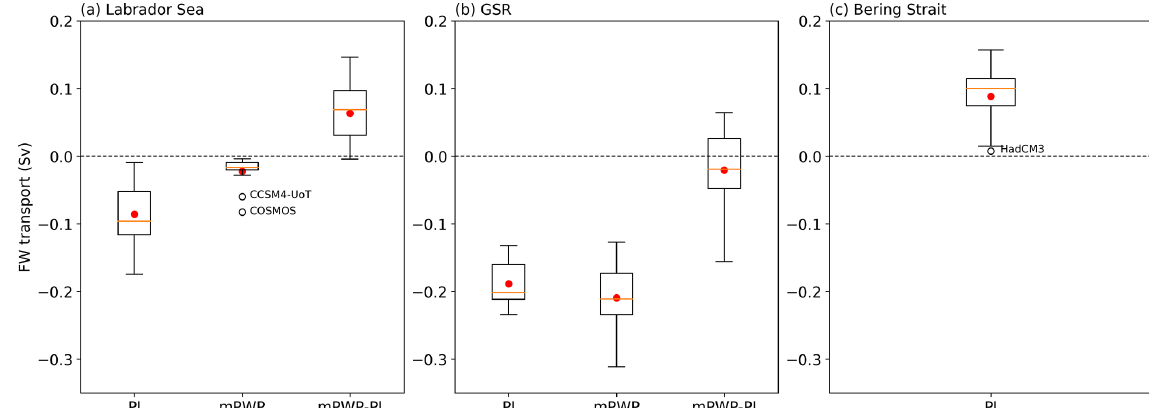
Figure 8. Boxplots of the mean freshwater transport (Sv) in the pre-industrial and mid-Pliocene and their difference at 62 ◦ N (a) near the northern boundary of the Labrador Sea and (b) across the GSR. (c) Mean freshwater transport (Sv) through the Bering Strait in the pre- industrial. The box covers Q 1 (25th percentile) to Q 3 (75th percentile), with the median indicated by a horizontal orange line. The whiskers extend from Q 1 to Q 1–1.5 × IQR (interquartile range) and from Q 3 to Q 3 + 1 . 5 × IQR, where IQR = Q 3 − Q 1. A model that falls outside the whiskers is separately shown as an unfilled circle. The MMM is indicated by a filled red